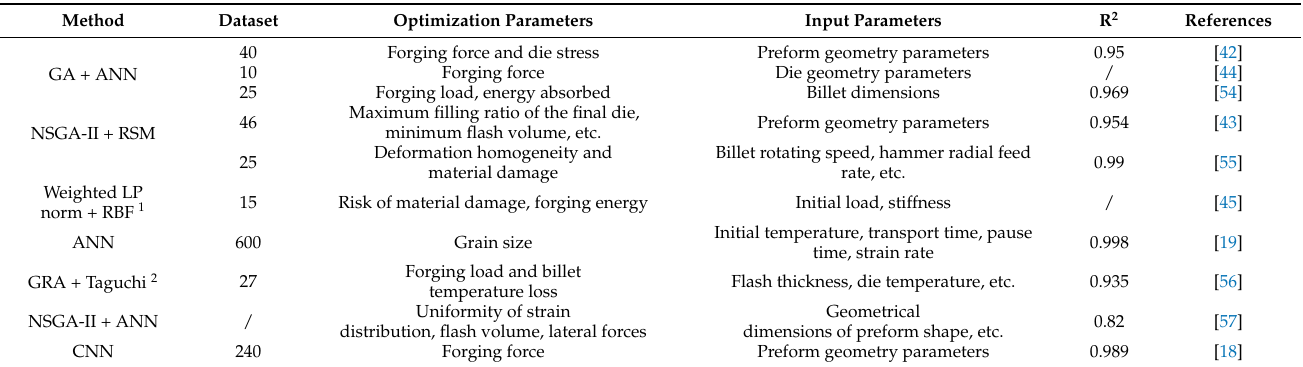
Table 2. A summary of intelligent optimization methods for